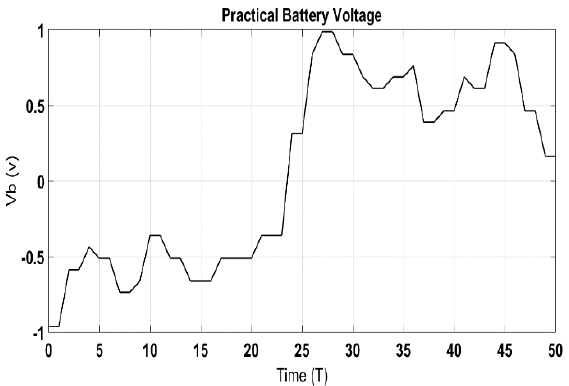
Figure 11. AC part of measured battery